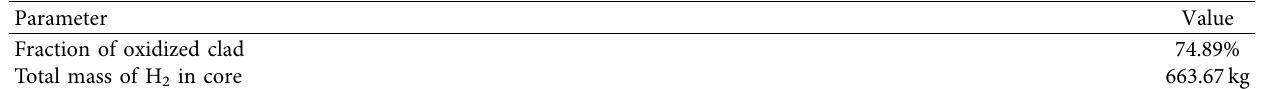
Table 19: Key figures of merits with PAR